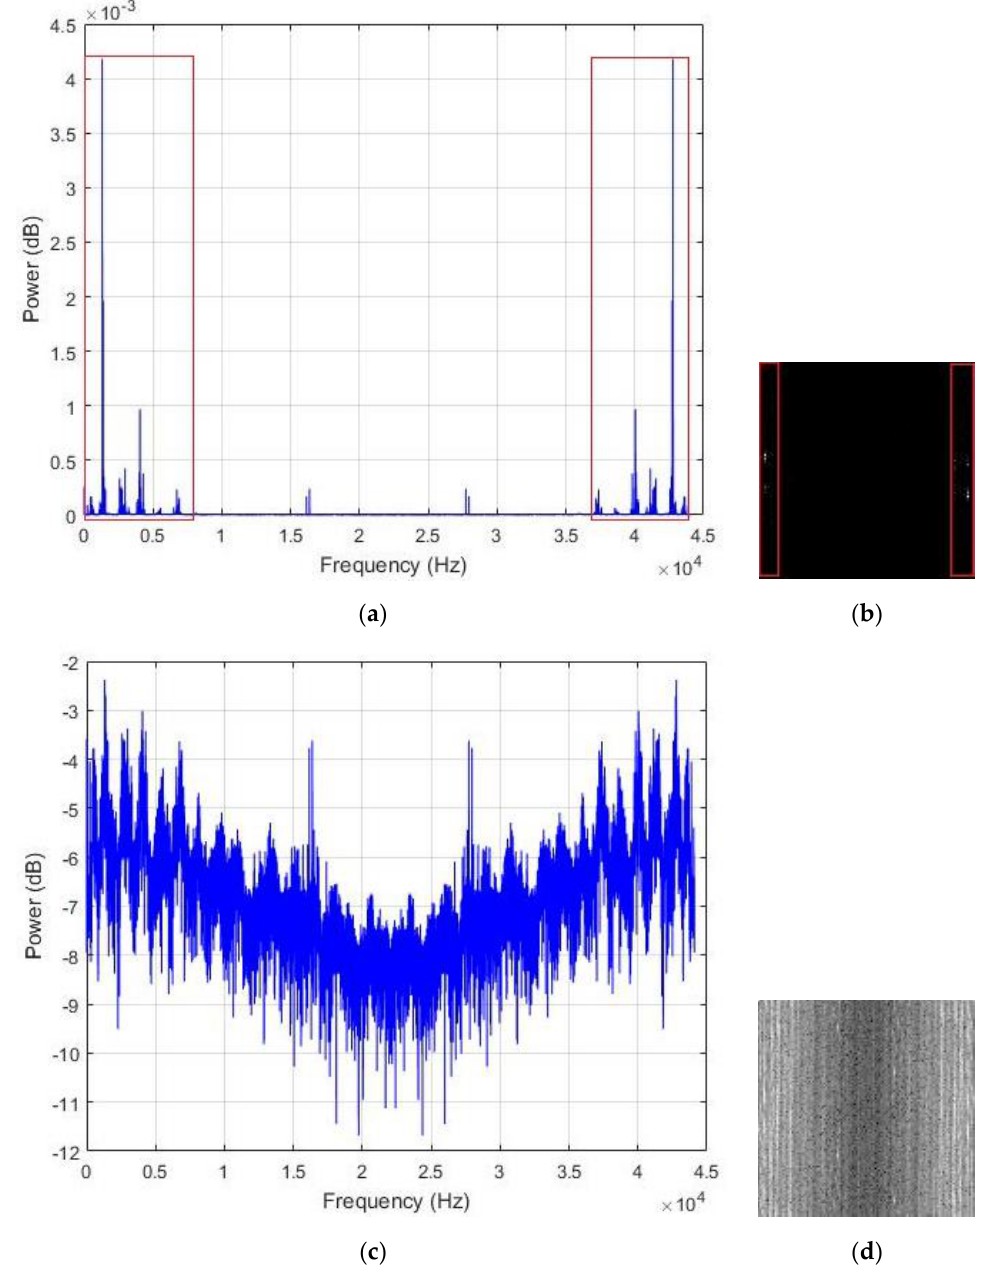
Figure 6. ( a ) The power spectrum of an example data where the low frequency regions with maximal energy are marked in red. In ( b ), the corresponding image, with the low frequency bands also marked in red. In ( c ), we have the logarithmic scale representation of the power spectrum, and in ( d ), its resulting image.